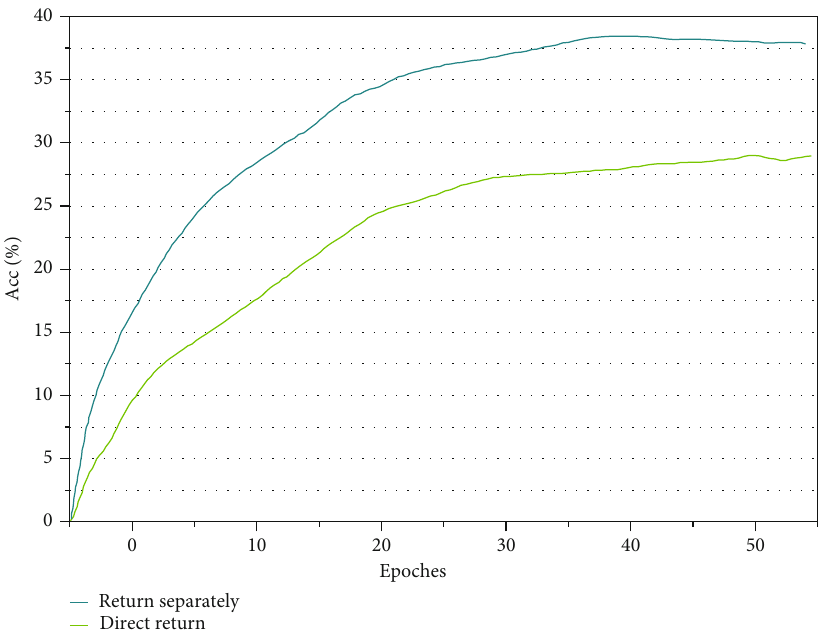
Figure 5: The trend of o ff set vector regression accuracy with training rounds on the validation